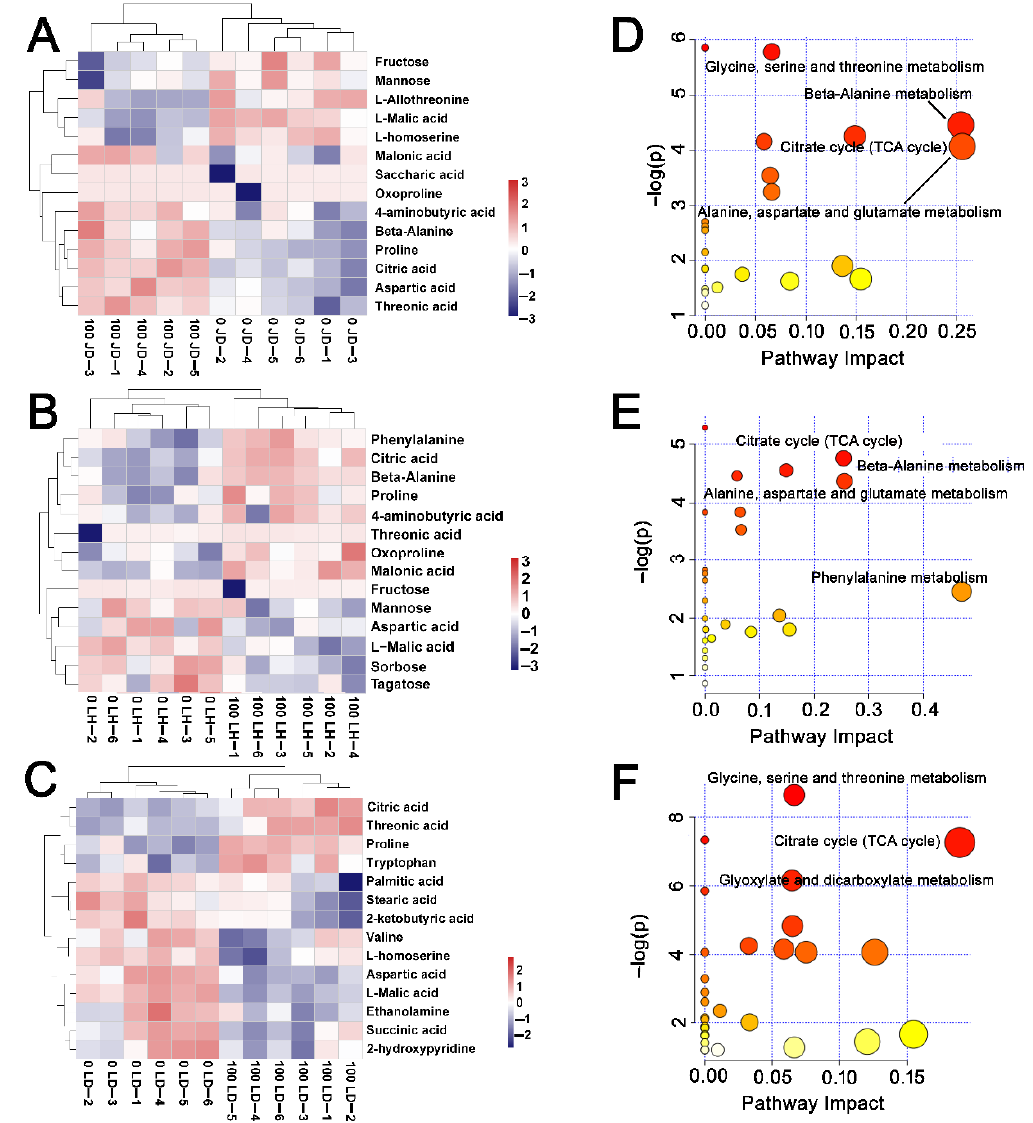
Figure 6. Heatmap clustering analysis of differentially expressed metabolites in ( A ) JD19, ( B ) LH3, ( C ) LD2, and KEGG pathway enrichment analysis in ( D ) JD19, ( E ) LH3, ( F ) LD2 under control and 100 mM NaCl treatment. Each bubble represents a metabolic pathway. The size of bubbles in abscissa represents the magnitude of the impact factor of the pathway in the topological analysis, with larger bubbles indicating higher impact factors. The bubble color in ordinate represents the p values of the enrichment analysis, with darker color indicating a more significant enrichment degree.